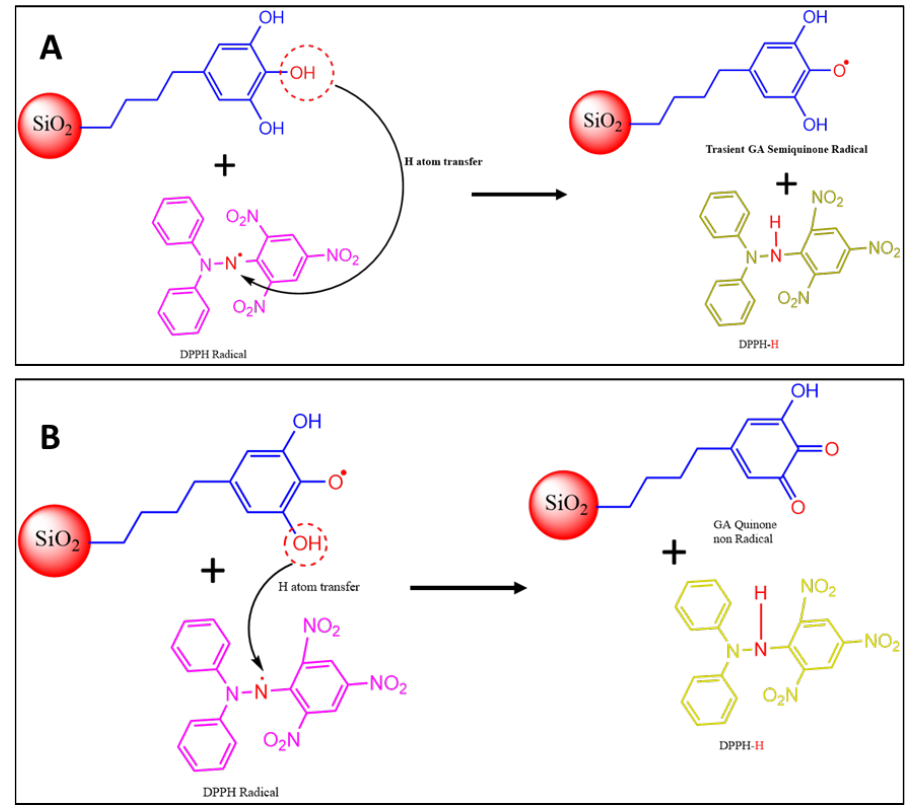
Figure 9. ( A ) Through the H atom transfer (HAT) process from the GA (gallic acid) molecule, one DPPH radical is scavenged by two SiO 2 -GA nanoparticles, resulting in the formation of a transitory GA radical. ( B ) HAT from the GA semiquinone results in the formation of a nonradical GA quinone, which SiO 2 -GA nanoparticles scavenge. However, MSN coated with caffeic acid (MSN-CAF) or rutin (quercetin 3-O-[-l- rhamnosyl-(1-6)-d-glucopyranoside]) was examined for its antioxidative stress proper- ties. To prevent ROS formation and biological damage, these catechol antioxidants have ortho- and meta-hydroxyl groups in their catechol structure that can scavenge or donate hydrogen atoms to free radicals. Caco-2 and HaCaT cell lines were employed to evaluate ROS generation, the activation of the Keap1-Nrf2 pathway, and cell death induced by free and functionalized MSNs in two cellular models (Figure 2). The antiradical test (ox- ygen radical absorbance capacity (ORAC)) was also used to investigate the antiradical characteristics of free or grafted antioxidant compounds. MSN-RUT had a Trolox equiv- alent level at 30.3 g/mL, which is much higher than that of naked nanoparticles or ami- no-propyl functionalized silica nanoparticles (MSNNH 2 ), and its antiradical function was determined to be 3.7 times more than that of MSN.